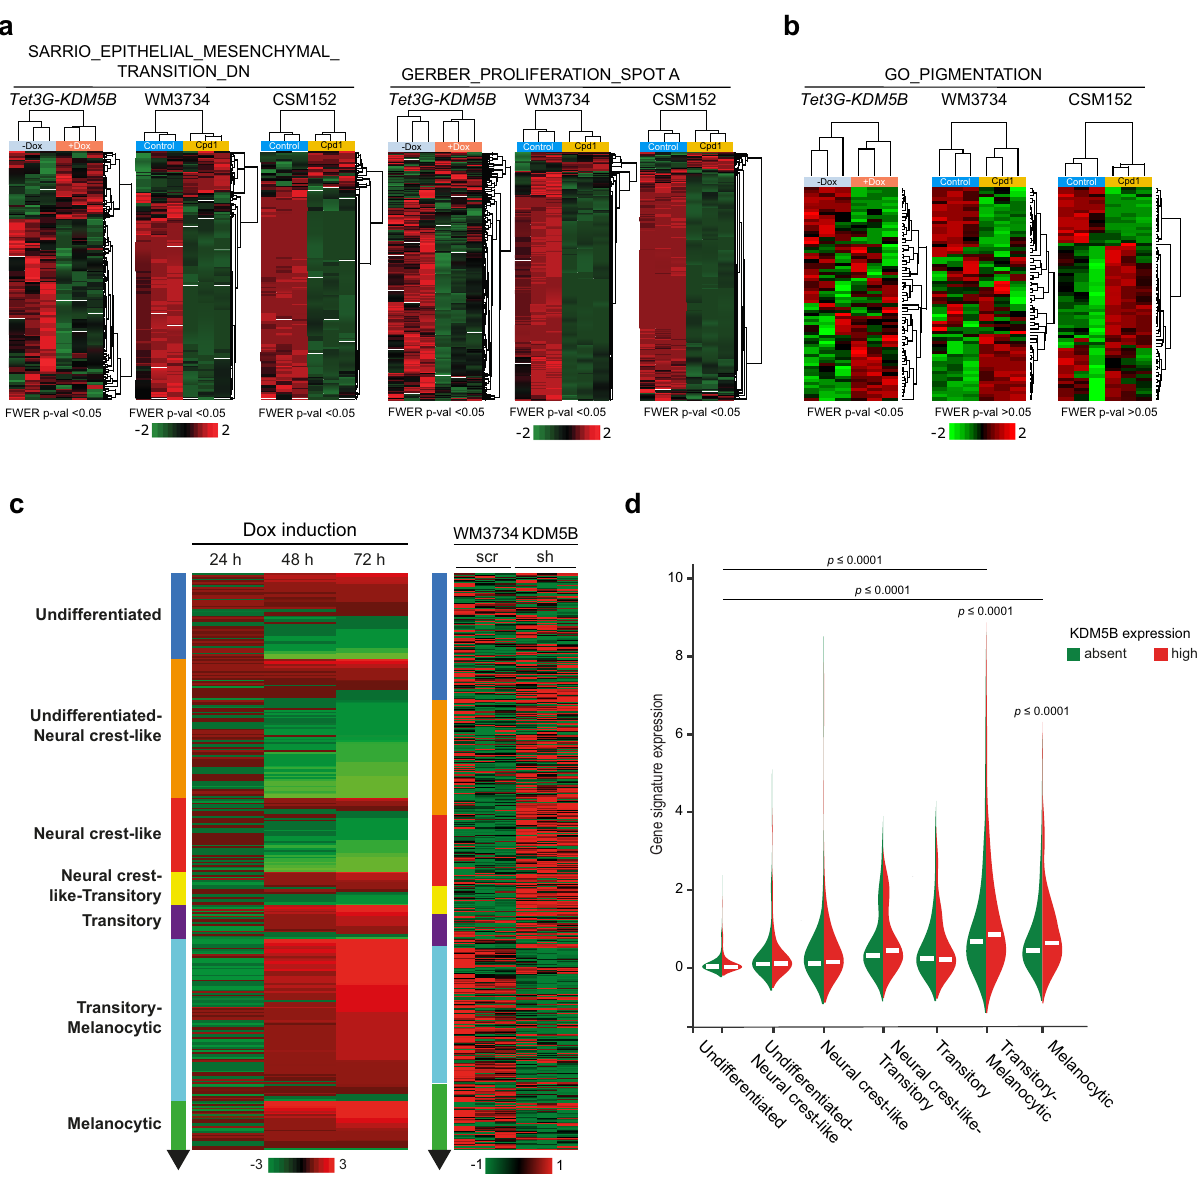
Fig. 4 KDM5B leads to a differentiation-directed phenotypic shift. a , b Heatmaps of the SARRIO_EPITHELIAL_MESENCHYMAL_TRANSITION_DN 36 , GERBER_PROLIFERATION_SPOT A signatures 37 ( a ) and GO_PIGMENTATION signature 38,39 ( b ) from WM3734 Tet3G-KDM5B cells after 72 h of Dox treatment and WM3734 and CSM152 cells after 72 h of Cpd1 treatment; red, upregulated; green downregulated genes. Signi fi cance is indicated by FWER p < 0.05. c Heatmap of the Tsoi differentiation trajectory 66 for WM3734 Tet3G-KDM5B cells after 24, 48, and 72 h Dox treatment (left), WM3734 KDM5B knockdown (sh) versus control (scr) cells (right); red, upregulated, green downregulated genes. d Violin plot displaying endogenous KDM5B expression levels according to the transcriptional differentiation level in single-cell RNA-sequenced human melanomas. Asterisks represent a p value <0.0001 from one-way ANOVA with Dunnett ’ s multiple comparison test. Here the comparison was made to the undifferentiated